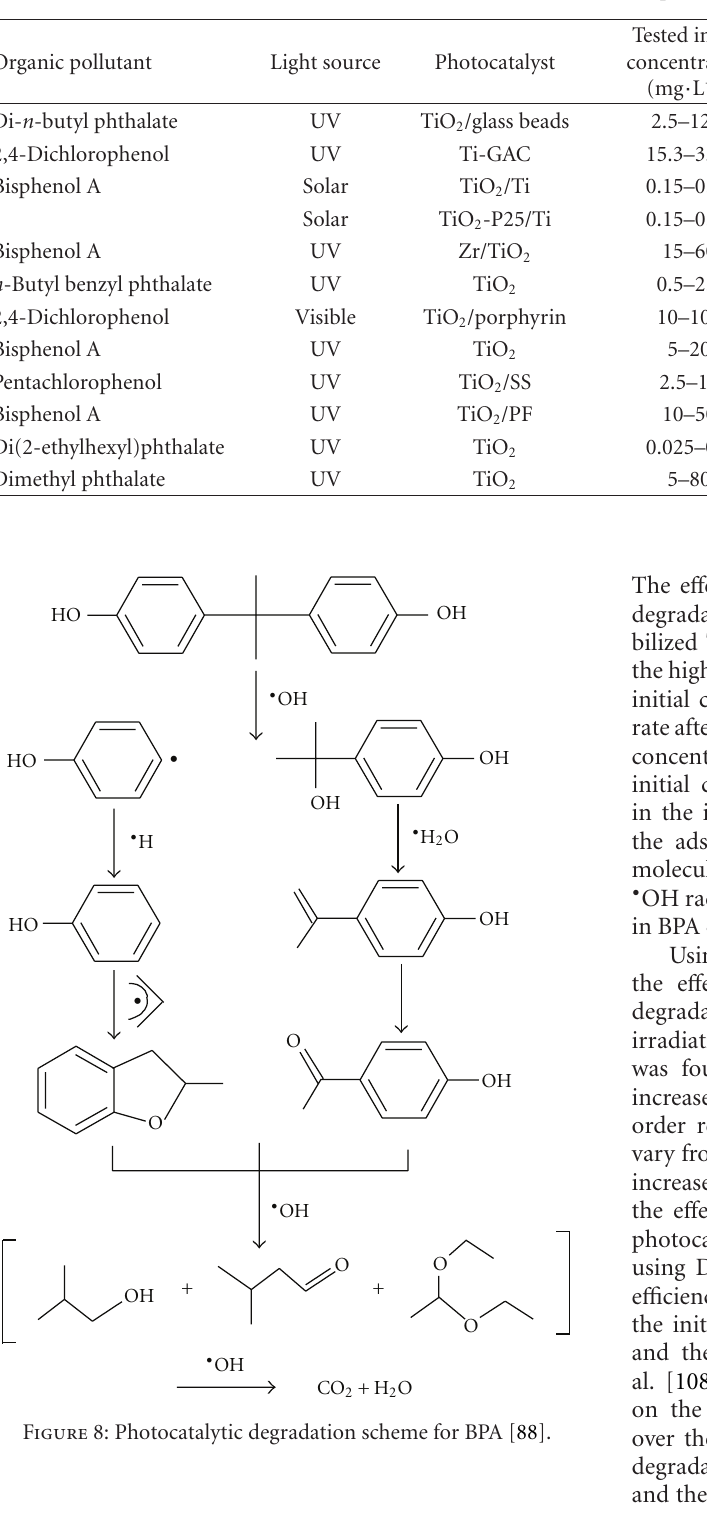
[103] investigated the e ff ect of initial concentration on the photocatalytic degradation of bisphenol A (BPA) in the presence of TiO 2 . After 10 h of UV irradiation, degradation e ffi ciencies of 78%, 55%, and 30% were obtained for initial BPA concentration of 10, 50 and, 100 mg · L − 1 ,